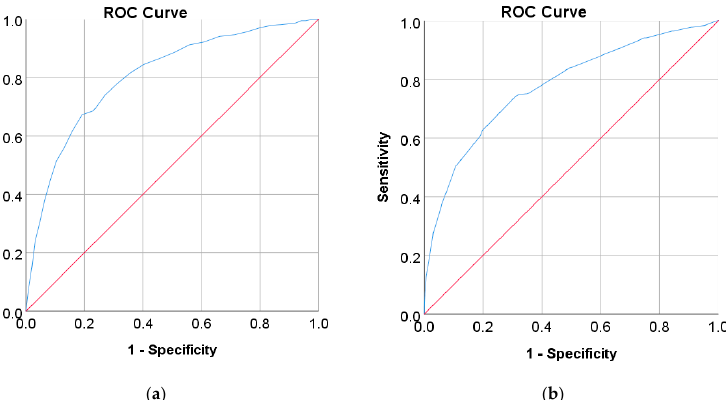
Figure 5. ROC curve for ( a ) FPG and ( b ) HbA1c values as a screening test on the Japanese diabetes adult population; FPG and HbA1c were used as the gold standard; the straight line represents the reference line.